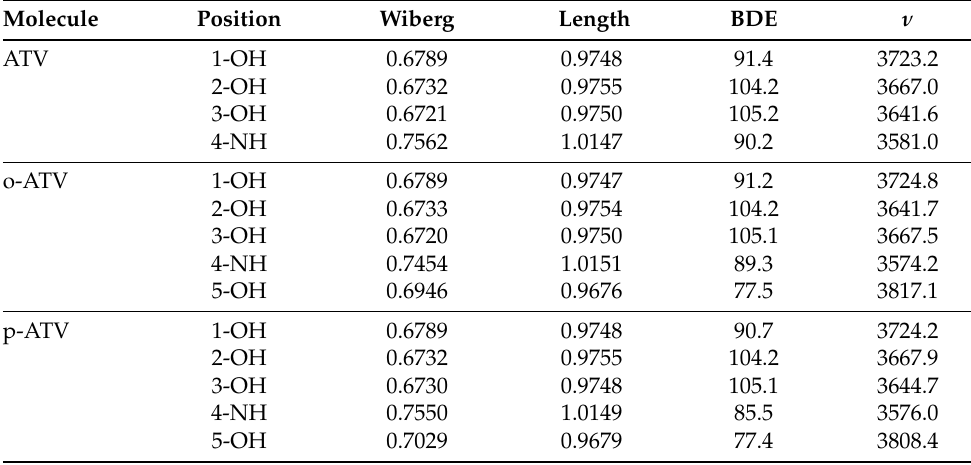
Table 6. Wiberg bond order indices, bond lengths (in Å), vibrational frequencies (in cm − 1 ), and bond dissociation energies BDE (in kcal/mol) for atorvastatin and its metabolites. Molecule